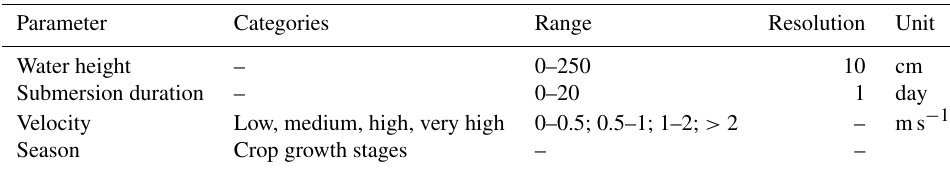
Table B1. Ranges and resolution of the flood parameters used in